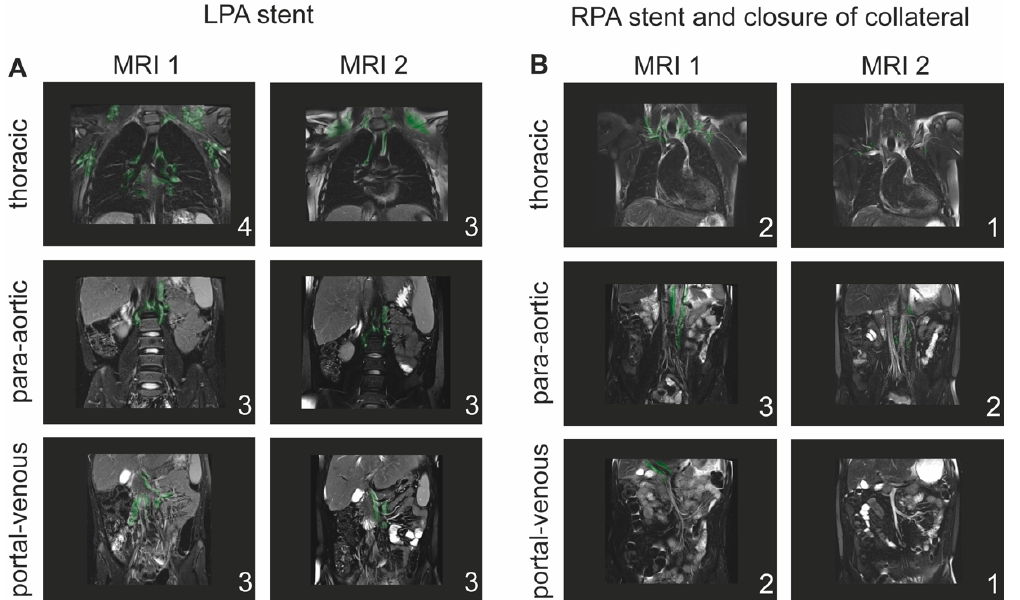
Figure 4. Example of lymphatic abnormalities after cardiac catheter intervention. ( A ) Patient who underwent first cardiac MRI at 13 years of age showing moderate left pulmonary artery (LPA) stenosis. The T2-weighted imaging showed significant thoracic lymphatic abnormalities (type 4) and para-aortic and portal-venous abnormalities type 3. The 2nd MRI was performed after cardiac catheterization and LPA stent implantation showing mildly improved thoracic lymphatic abnormalities. ( B ) 25-year-old Fontan patient in good clinical condition presented with significant stenosis of the right pulmonary artery (RPA) on 1st MRI. Cardiac catheter intervention with balloon dilatation of the RPA and closure of a major aortopulmonary collateral (MAPCA) from the descending aorta was performed. Repeat MRI at the age of 30 years showed improvement in lymphatic abnormalities in all three compartments. Lymphatic abnormalities are highlighted in green.